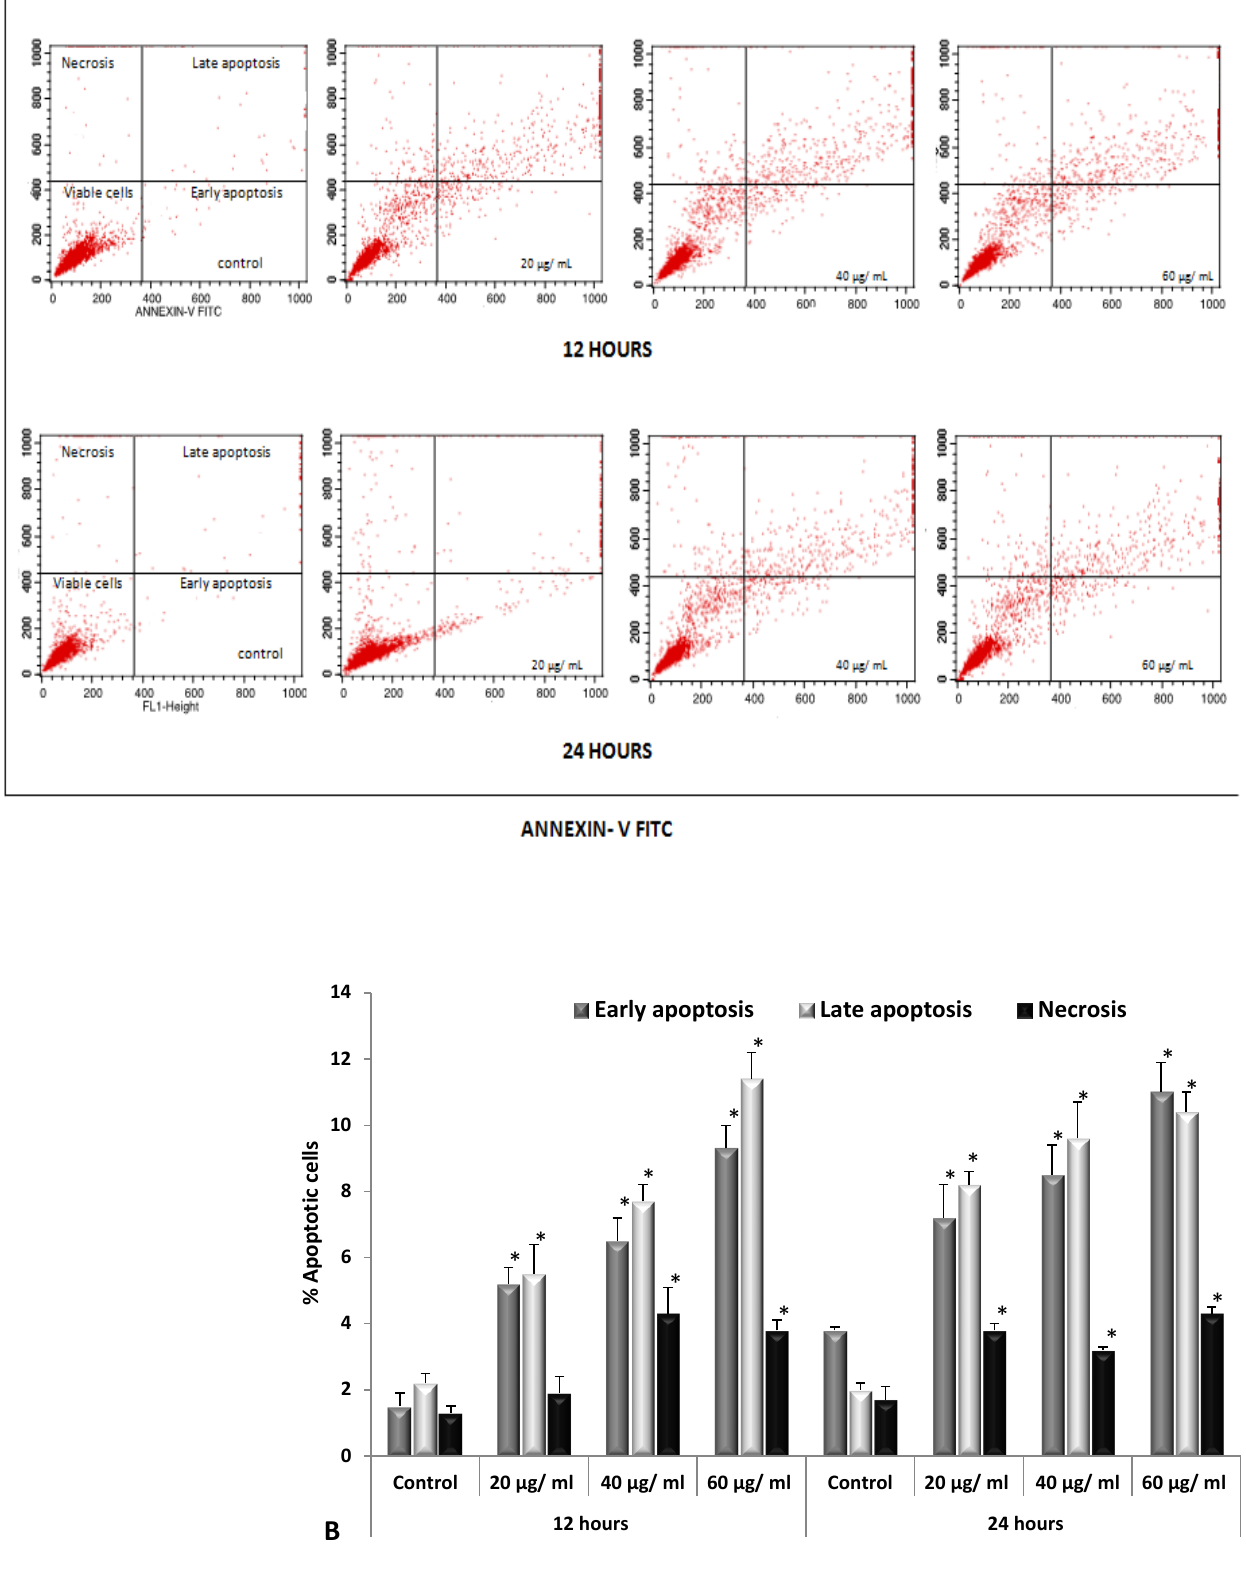
Figure 10. Evaluation of apoptosis using annexin V-FITC/PI assay in HepG2 cells exposed to the different concentrations of SMAgNPs. Dot plots representing percentage of viable cells, early apoptotic cells, late apoptotic cells, and necrotic cells after 12 and 24 h ( A ). Bar diagram showing the percent of apoptotic cells relative to the control ( B